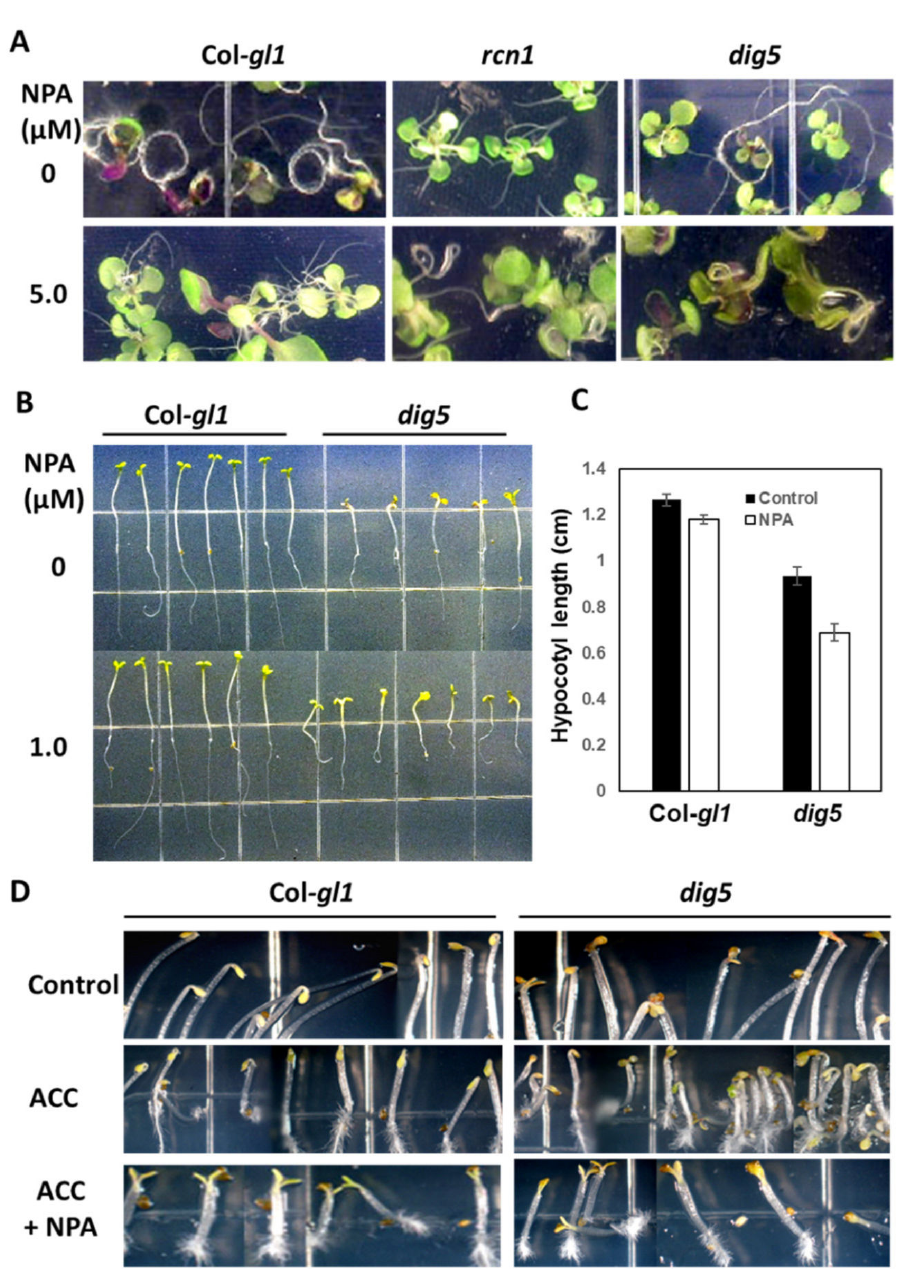
Figure 4. Abnormal root curling and apical hook formation of dig5 mutants. ( A ) Root curling of Col- gl1 , rcn1 , and dig5 seedlings in the absence or presence of 5 µ M NPA. (B) Hypocotyl elongation of Col- gl1 and dig5 in the absence or presence of 1.0 µ M NPA. ( C ) Hypocotyl length of seedlings in ( B ). Data are means and standard deviation from 18 seedlings. ( D ) Apical hook formation